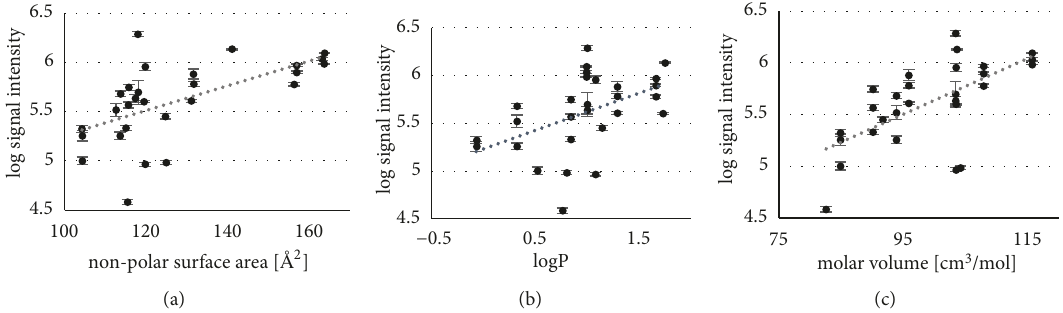
Figure 4: Log signal intensity (peak height) of APCI measurements in dependency on (a) the nonpolar surface area (SciFinder), (b) log P (ChemAxon), and (c) the molar